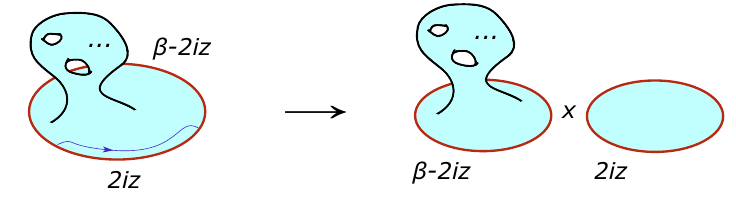
Figure 22 . A graphical representation of the near horizon metric (left). A sum over the gluing parameter (cid:22) is implicit in the handlebody. For large z the Wilson line pinches o(cid:11) the space (right) and we obtain